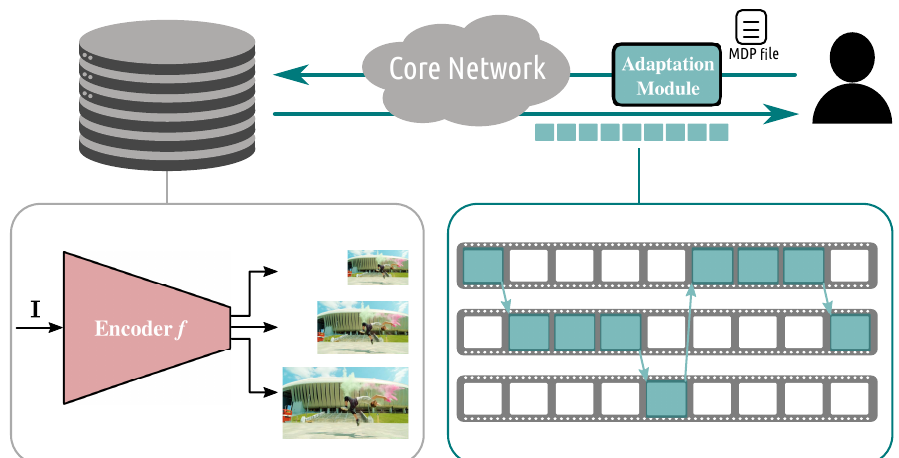
Figure 4. Adaptive video streaming over HTTP. After encoding the video into multiple represen- tations (e.g., resolutions, qualities, etc.), it is stored in a server from where it can be delivered to the users. Before watching the video, users first obtain the MDP file, which contains information where the video is stored (typically, the video is split into chunks of 2–5 s), it acquires the video. The representation of the video displayed to the users is decided by the users and depends on the encountered channel conditions and other quality factors. The adaptation logic can be either based on control theory approaches or machine learning. The latter permits the consideration of multiple quality factors and forecasting future changes in the network